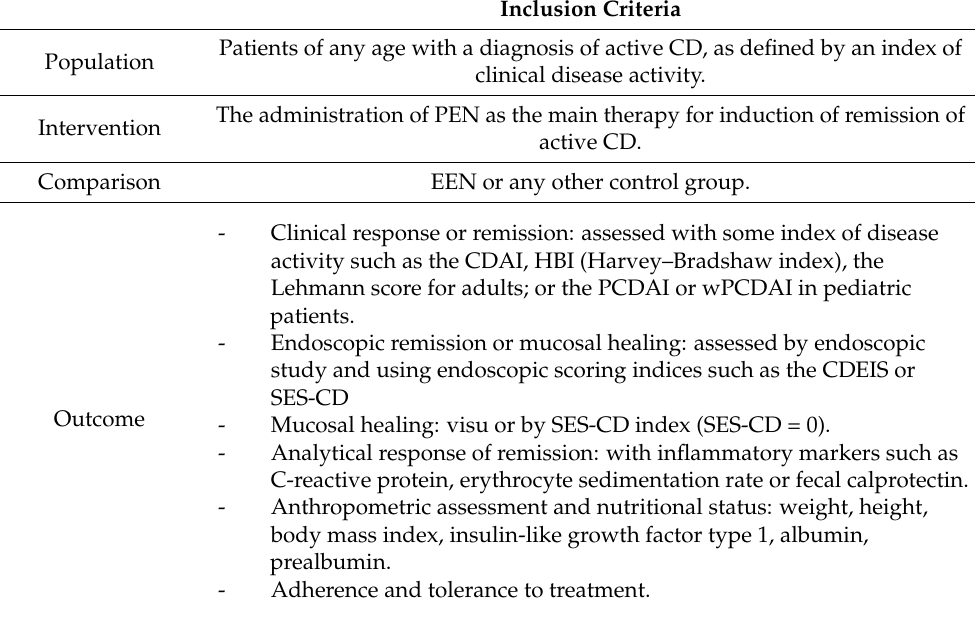
Table 1. Population, Intervention, Comparison, and Outcome (PICO) criteria [27] for the inclusion of studies on the efficacy of partial enteral nutrition for induction of Crohn’s disease remission. Inclusion Criteria Patients of any age with a diagnosis of active CD, as defined by an index of Population clinical disease activity. The administration of PEN as the main therapy for induction of remission of Intervention